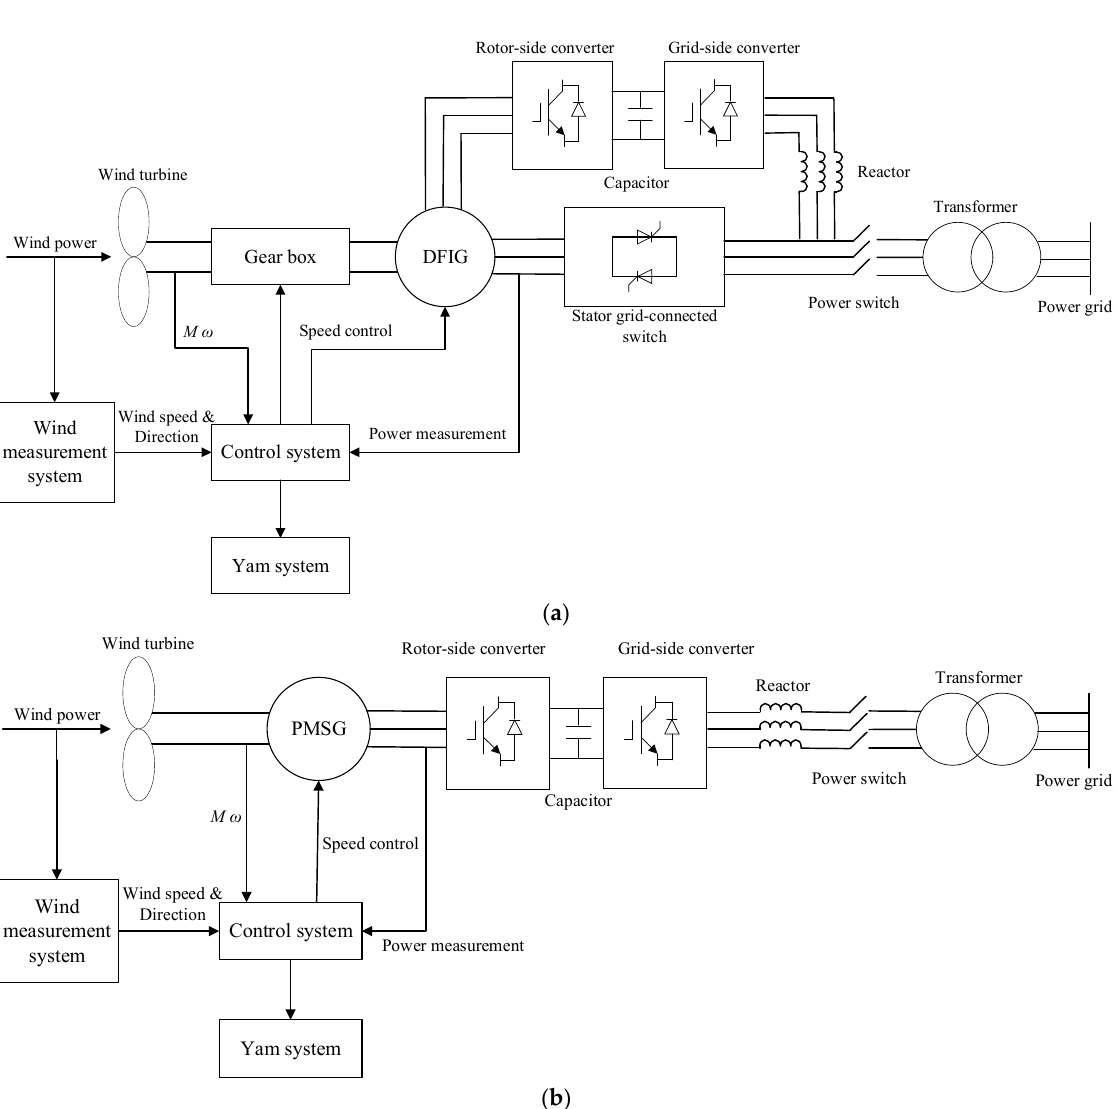
Figure 6. Technology development trends of offshore wind turbines.